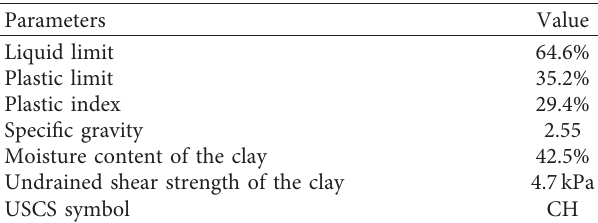
Figure 1: Typical photograph of the geogrid encasement. Table 2: Properties of the clay